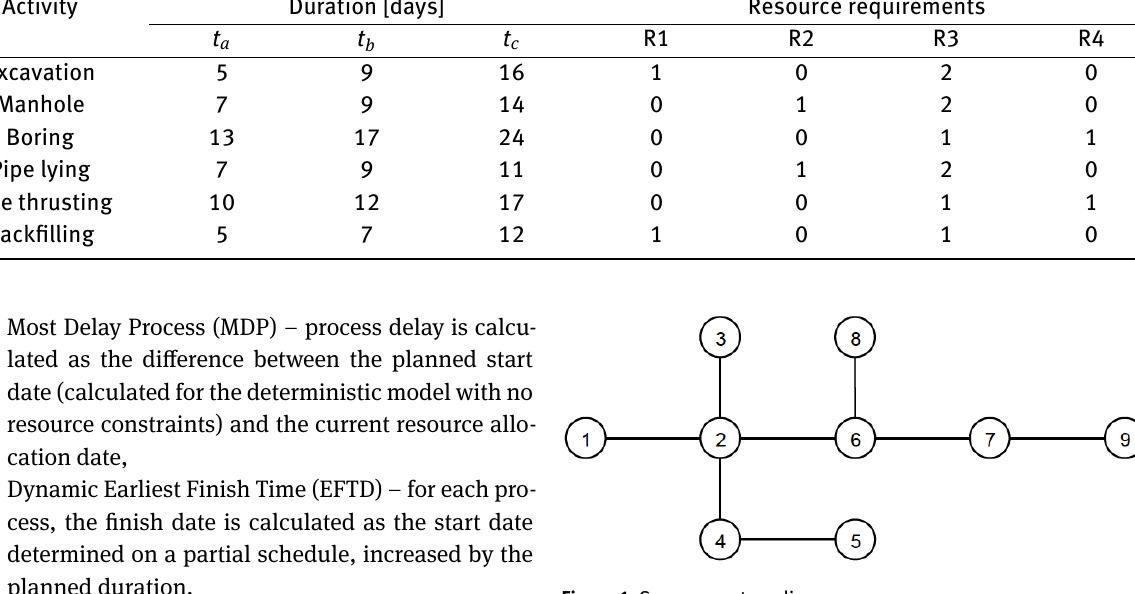
Table 1: Duration, type, and number of resources for individual activities Activity